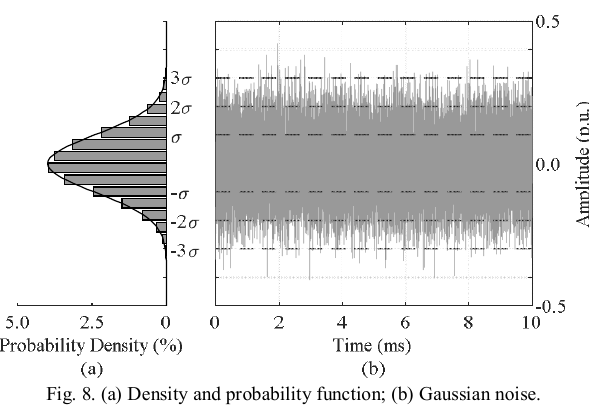
Fig. 8. (a) Density and probability function; (b) Gaussian noise. The response of the density and probability function is shown in Fig. 8 (a), while in Fig. 8 (b) is the Gaussian noise along the time (applied in   N s ).